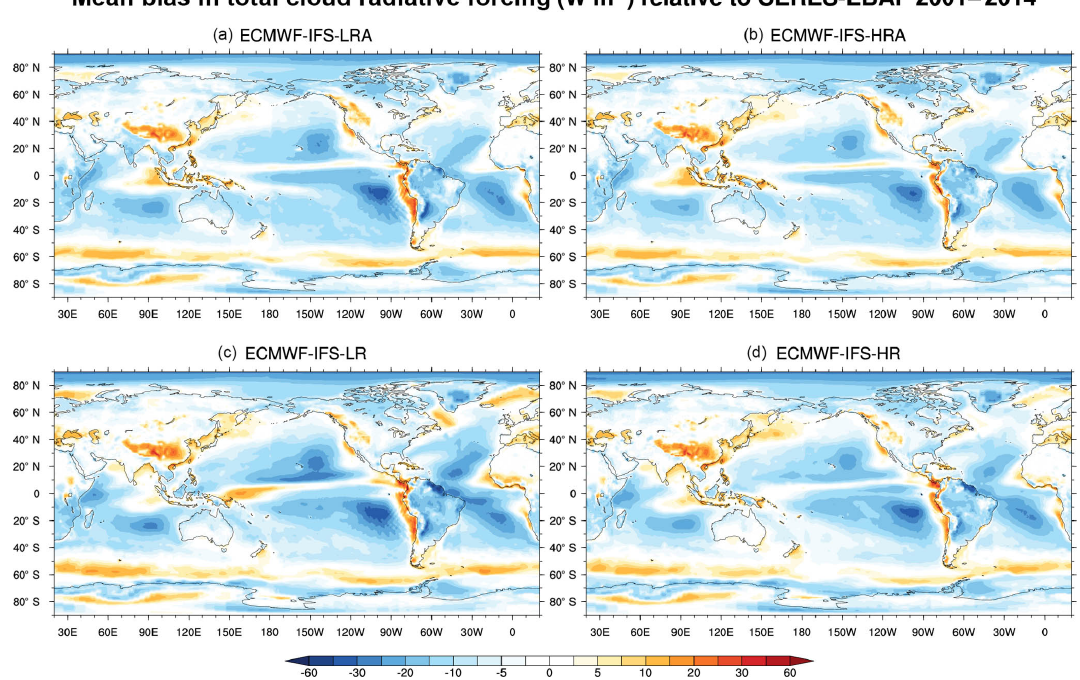
Figure 5. Annual mean bias in total cloud radiative forcing (CRF) in (a–b) highresSST-present and (c–d) hist-1950 relative to data from Clouds and the Earth’s Radiant Energy System Energy Balanced and Filled product (CERES-EBAF) surface fluxes edition 4.0 (Kato et al., 2013).